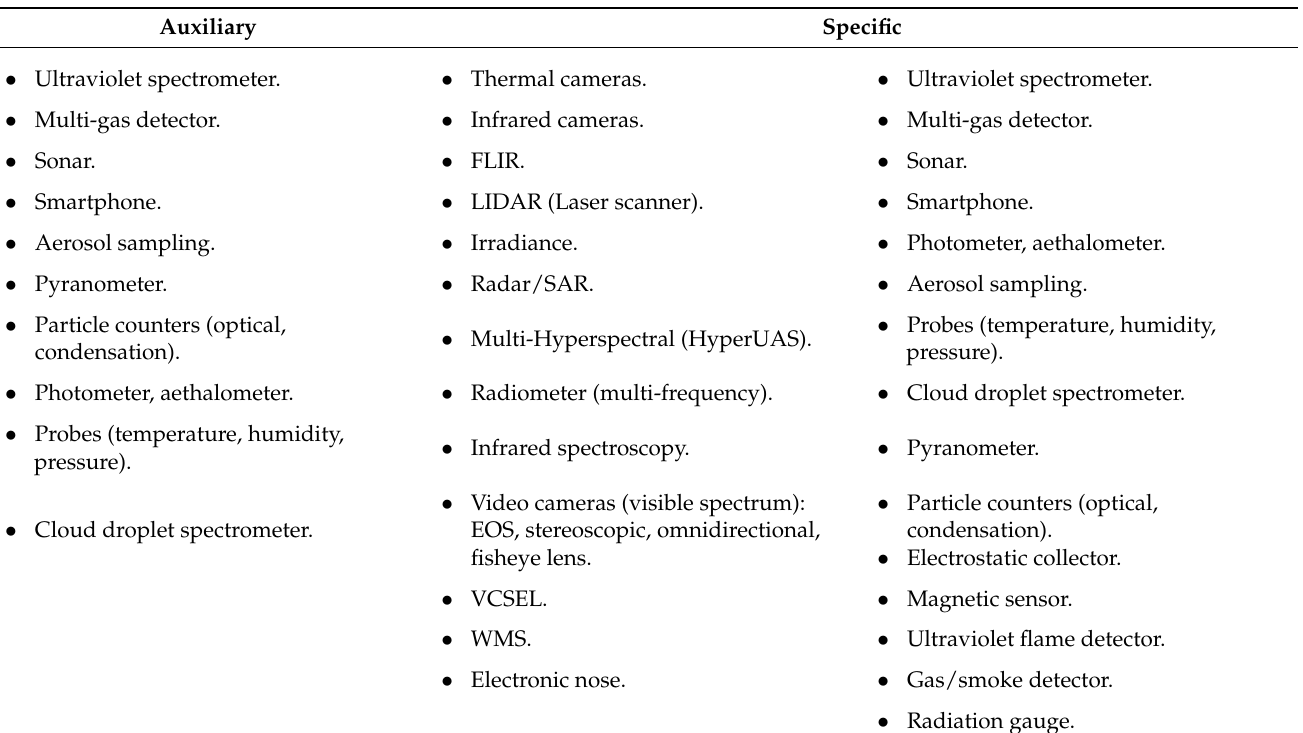
Table 3. Sensors Onboard Drones: Auxiliary and Specific [21]. Reprinted with permission from the American Society for Photogrammetry & Remote Sensing, Bethesda, Maryland, www.asprs.org/, accessed on 6 January 2021.